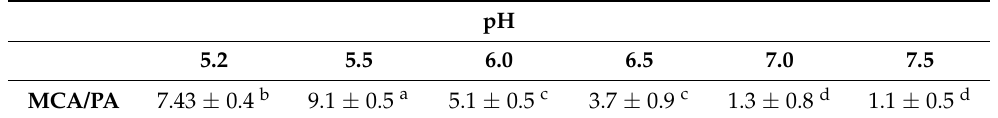
Table 3. Comparison between yield of curds obtained with chymosin, microbial coagulant, and dif- ferent aliquots of aqueous extract from ripe kiwifruit.